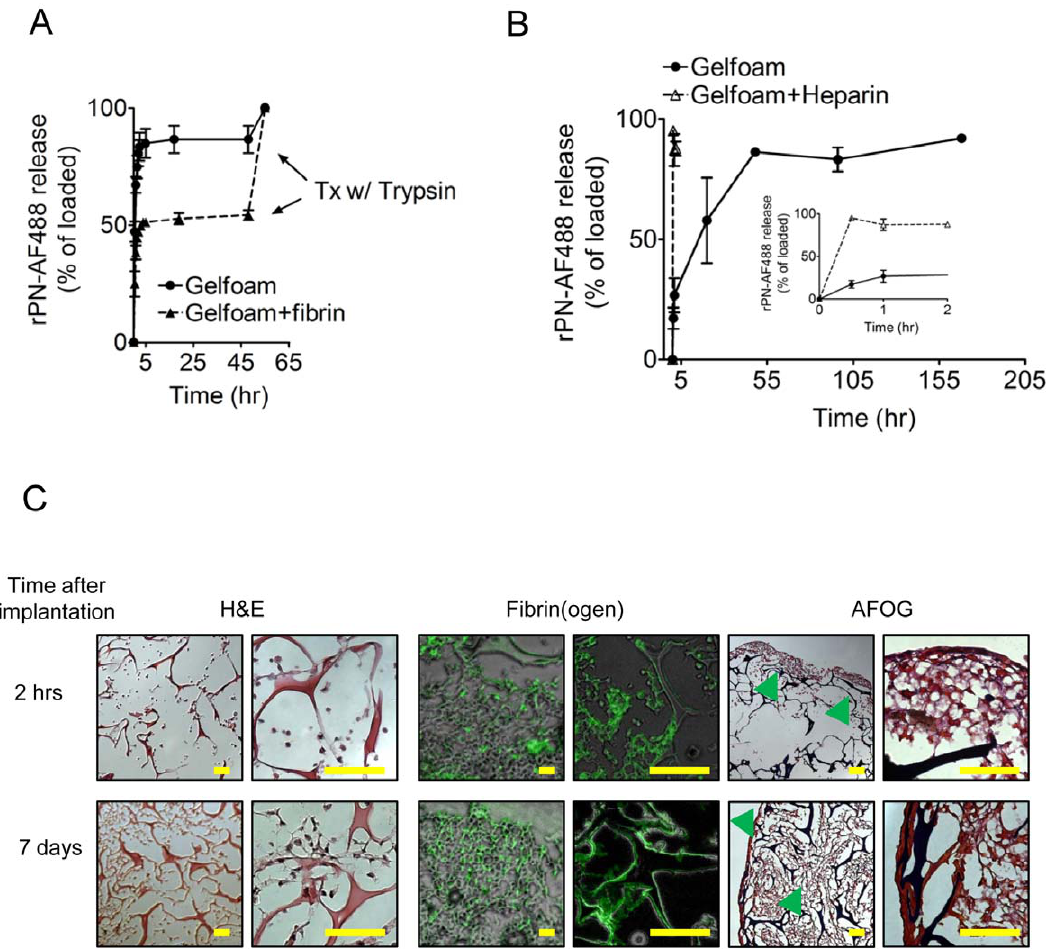
Figure 2. Fibrin encased Gelfoam hydrogels prolong rPN release In Vitro and In Vivo. (A) In vitro release kinetics of fluorescently-labeled rPN (rPN-AF488) from Gelfoam and Gelfoam-Fibrin composite hydrogels in PBS at 4 u C. (B) In vivo release kinetics of rPN-AF488 from Gelfoam and Gelfoam/Heparin hydrogels implanted within the peritoneal cavity of mice. (C) Gelfoam sponges loaded with rPN –AF488 were explanted and characterized by immunohistochemistry and immunofluorescence. Sections were stained with hemotoxylin and eosin (H&E), fibrin(ogen), and acid fuschin orange –G (AFOG). Green arrows indicate fibrin deposition within the Gelfoam sponge. Scale bars, 50 m m.